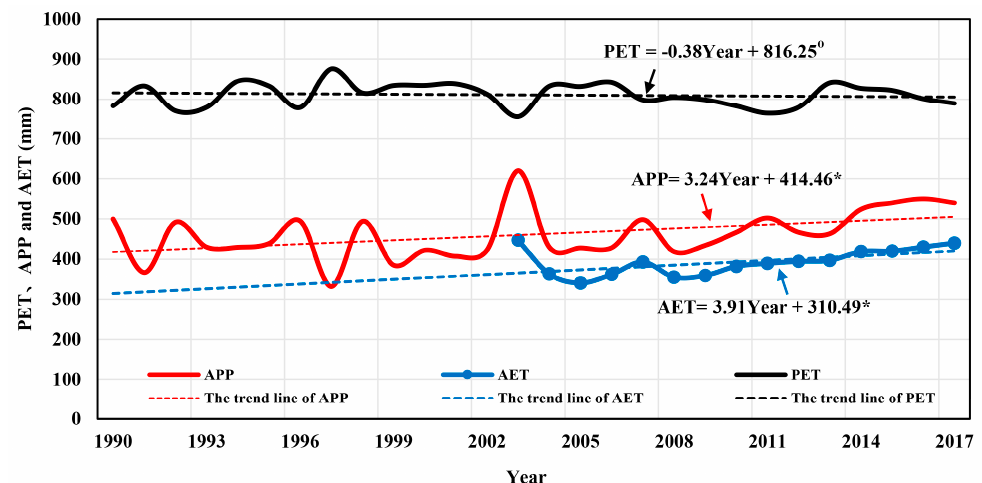
Figure 3. The temporal changing trend of the annual average precipitation (AAP) and regional potential evapotranspiration (PET) and AET (“*” means the changing trend is statistically significant at a 95% confidence level, and “o” means the changing trend is not statistically significant.).